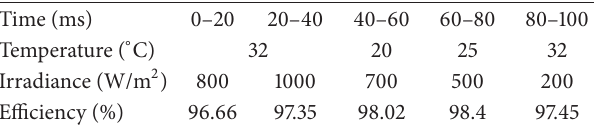
Figure 5: Implementation of CV technique.